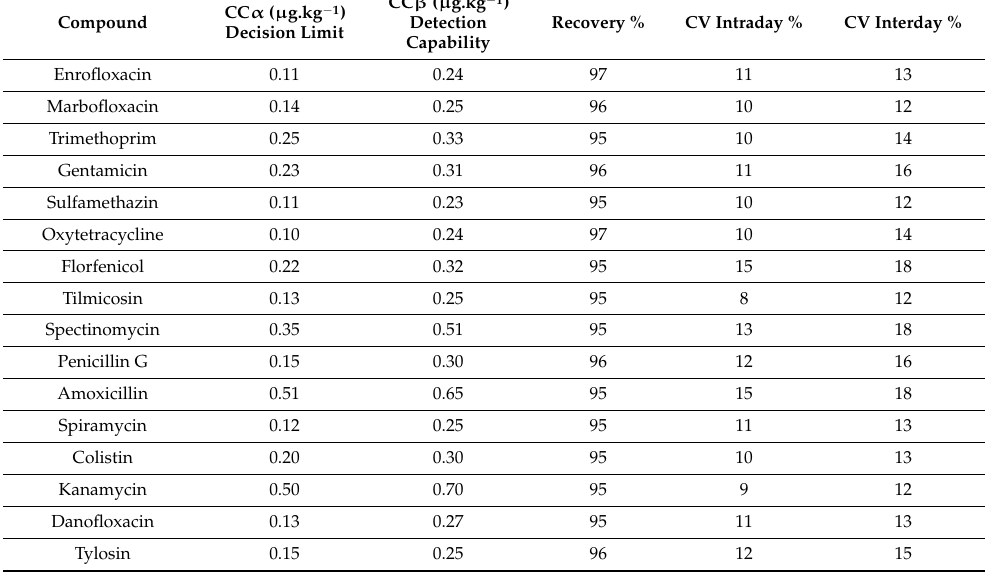
Table 2. Liquid chromatography and mass spectrometry analytical performance for antibiotics.